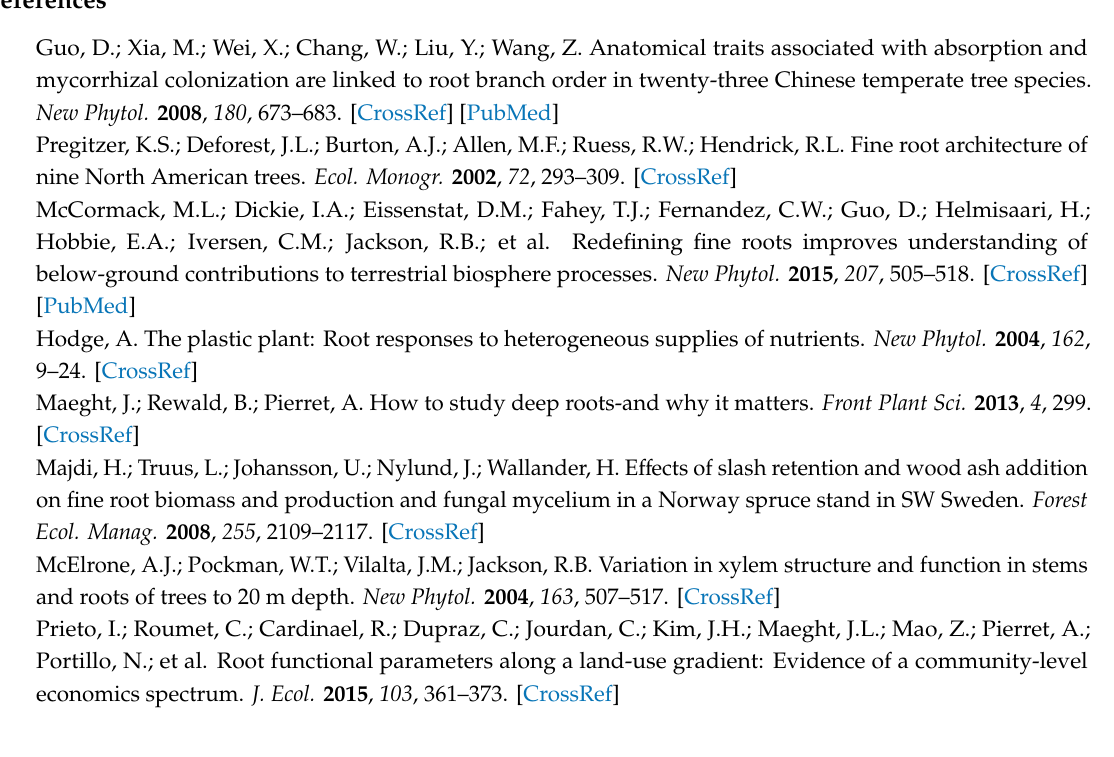
Table S1. The loadings scores of root functional traits of the first two PCA axes; Figure S1. Mean diameter, specific root length, root tissue density, and root branching density of the first five orders of roots in surface (0–10 cm) and subsurface (20–30 cm) soil layers for Juglans mandshurica (a, d, g, j), Fraxinus mandshurica (b, e, h, k), and Phellodendron amurense (c, f, i, l). The error bars represent 1 standard error of mean (SEM). Di ff erent lowercase letters within the clusters of bars indicate significant di ff erences ( p < 0.05) in root traits between soil layers according to Fisher’s LSD test. Figure S2. Root carbon concentration and the nitrogen and carbon concentration ratio in the first five orders of roots in surface (0–10 cm) and subsurface (20–30 cm) soil layers for J. mandshurica (a, d), F. mandshurica (b, e), and P. amurense (c, f). The error bars represent 1 SEM. Di ff erent lowercase letters within the clusters of bars indicate significant di ff erences ( p < 0.05) in root traits between soil layers according to Fisher’s LSD test. Figure S3. Root cortex thickness, stele diameter, and stele:root diameter ratio of the first five orders of roots in surface (0–10 cm) and subsurface (20–30 cm) soil layers for J. mandshurica (a, d, g), F. mandshurica (b, e, h), and P. amurense (c, f, i). The error bars represent 1 SEM. Di ff erent lowercase letters within the clusters of bars indicate significant di ff erences ( p < 0.05) in root traits between soil layers according to Fisher’s LSD test. Figure S4. Mean, maximum, and hydraulic weight conduit diameter and number of conduits per stele area in the first five orders of roots in surface (0-10 cm) and subsurface (20–30 cm) soil layers for J. mandshurica (a, d, g, j), F. mandshurica (b, e, h, k), and P. amurense (c, f, i, l). The error bars represent 1 SEM. Di ff erent lowercase letters within the clusters of bars indicate significant di ff erences ( p < 0.05) in root traits between soil layers according to Fisher’s LSD test. Figure S5. Theoretical hydraulic conductivity (Ks) of the first five orders of roots in surface (0–10 cm) and subsurface (20–30 cm) soil layers for J. mandshurica (a), F. mandshurica (b), and P. amurense (c). The error bars represent 1 SEM. Di ff erent lowercase letters within the clusters of bars indicate significant di ff erences ( p < 0.05) in root traits between soil layers according to Fisher’s LSD